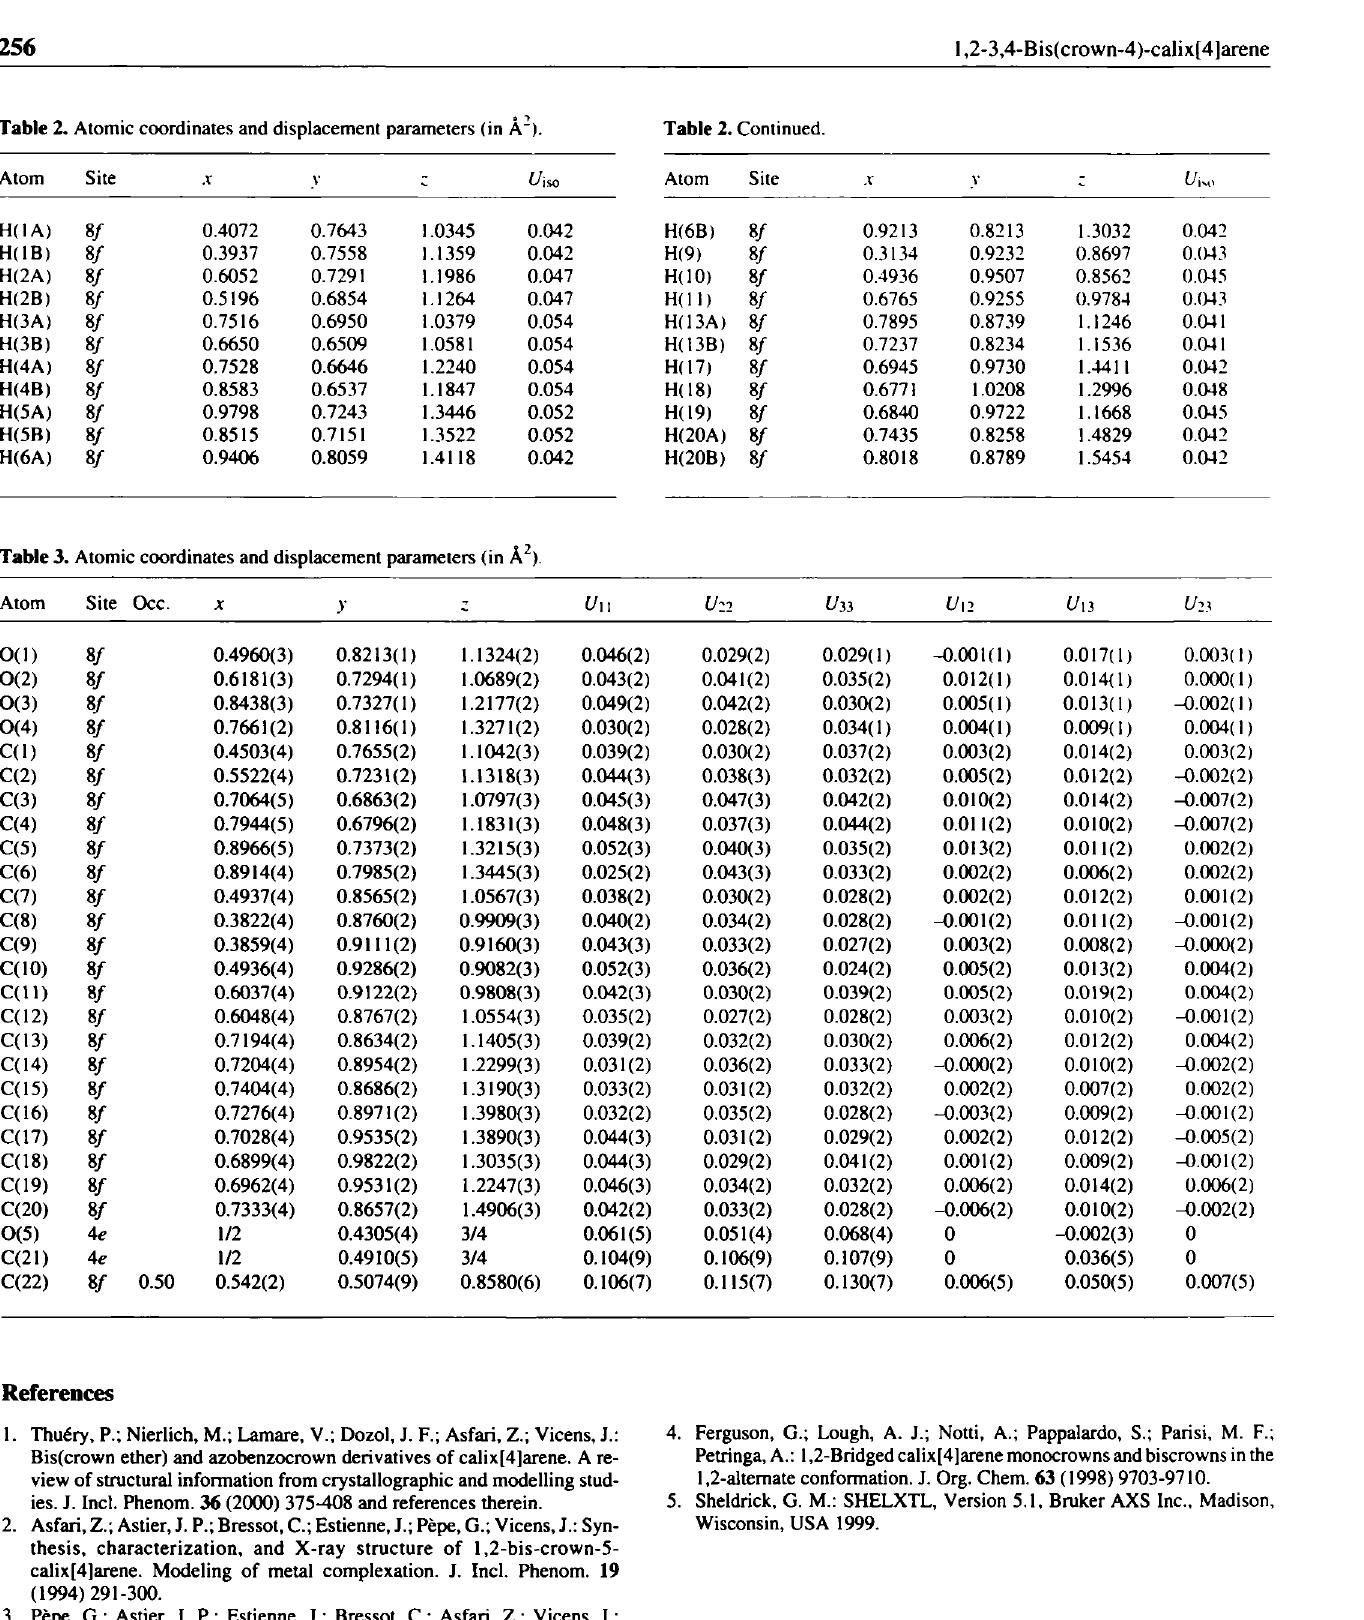
Table 2. Atomic coordinates and displacement parameters (in A~).